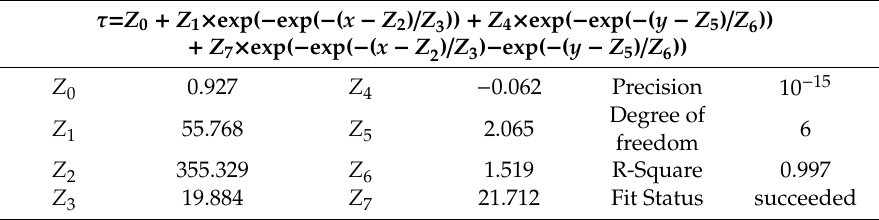
Table 3. Surface fitting equation of the time-shift factors.